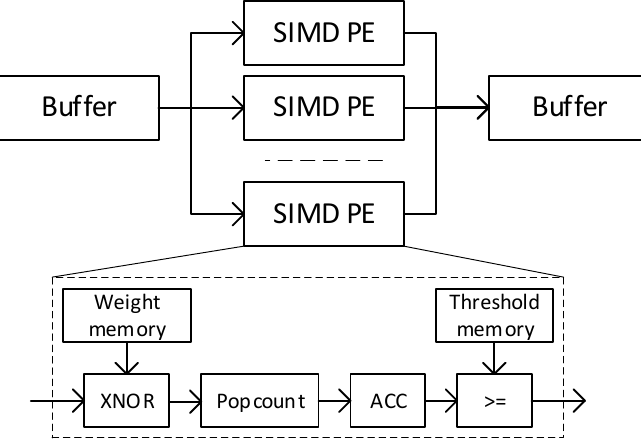
Figure 9. Architecture of the matrix-vector-threshold